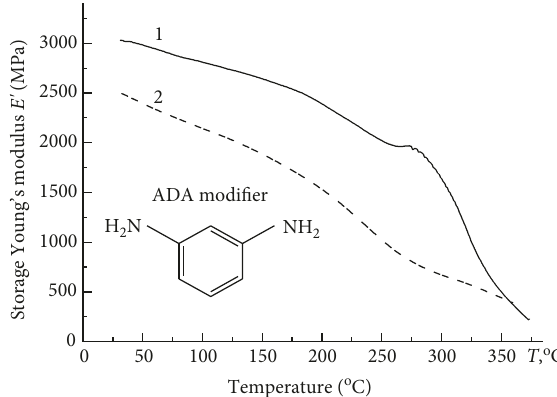
Figure 10: Temperature dependencies of storage Young ’ s modulus Е ′ of the cured ROL-I-1,3-PDA (I) blend (1) and the cured neat ROL-I (2). The DMA experiments were performed at a frequency ( ν ) of ~